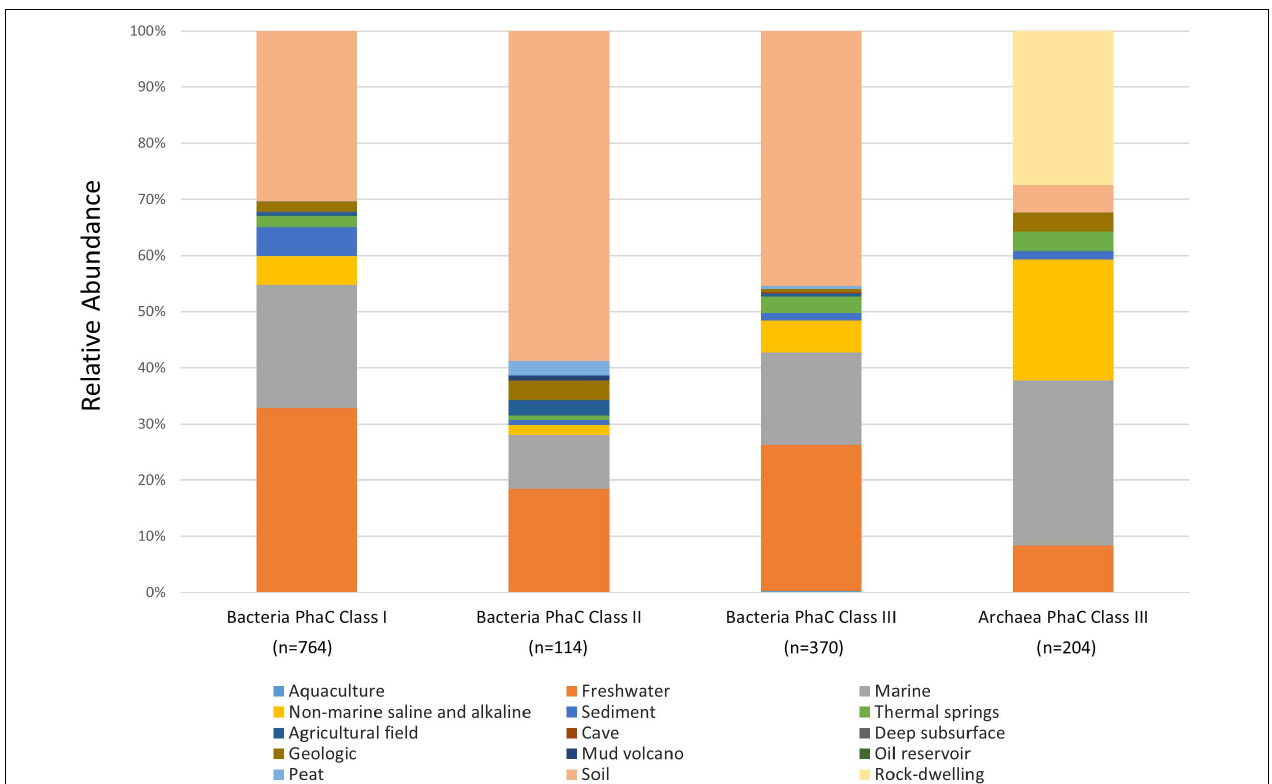
FIGURE 2 | Environmental distribution of bacteria and archaea PHA Synthase genotypes. The relative abundance of IMG Genomes with classified GOLD “Aquatic” or “Terrestrial” ecosystem